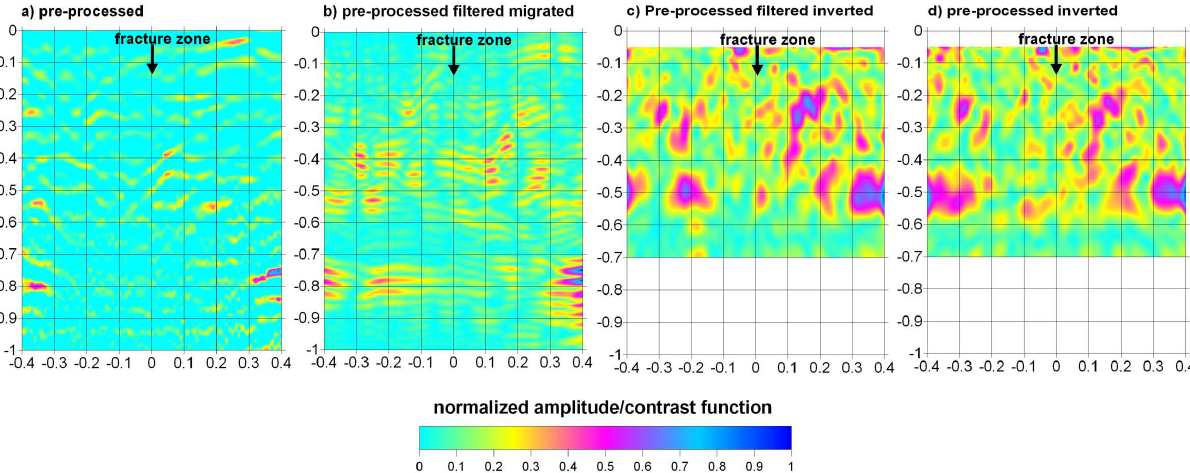
Fig. 3. Radargram carried out in correspondence of a wall of the Venizelos house. (a) preprocessed (raw) data; (b) time domain full processed data; (c) microwave tomography carried out on the pre-processed filtered data; (d) microwave tomography carried out on the pre-processed data in (a).